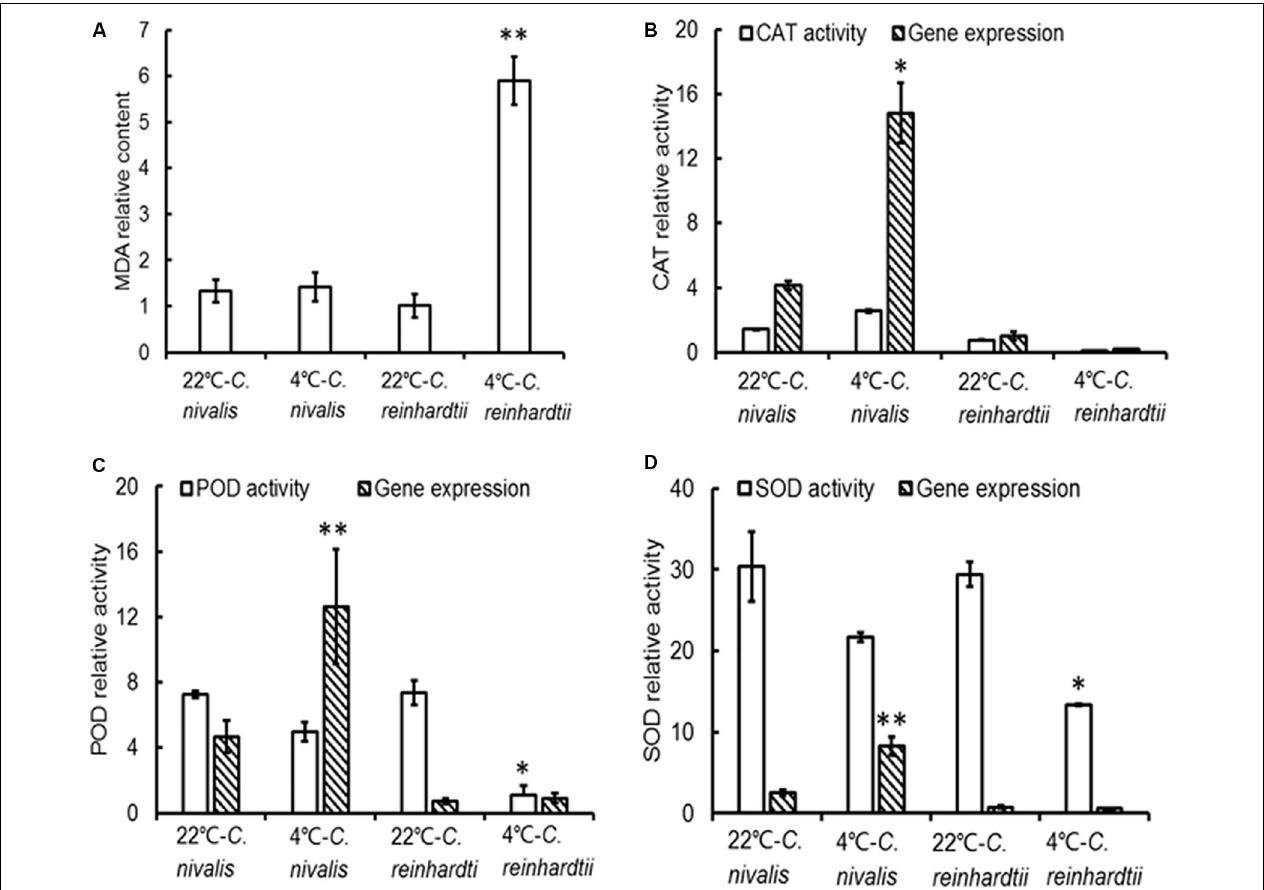
FIGURE 7 | MDA levels, antioxidant enzyme activities, and gene expression in C. nivalis and C. reinhardtii at 22 and 4 ◦ C. (A) MDA content (mg prot ml − 1 ). (B) CAT activity (U mg − 1 protein s − 1 ) and expression levels. (C) POD activity (U mg − 1 prot) and expression levels. (D) SOD activities (U mg − 1 prot) and expression levels. The significance of the differences between 22 and 4 ◦ C in the same strain were tested using a one-way ANOVA. * p < 0.05, ** p <